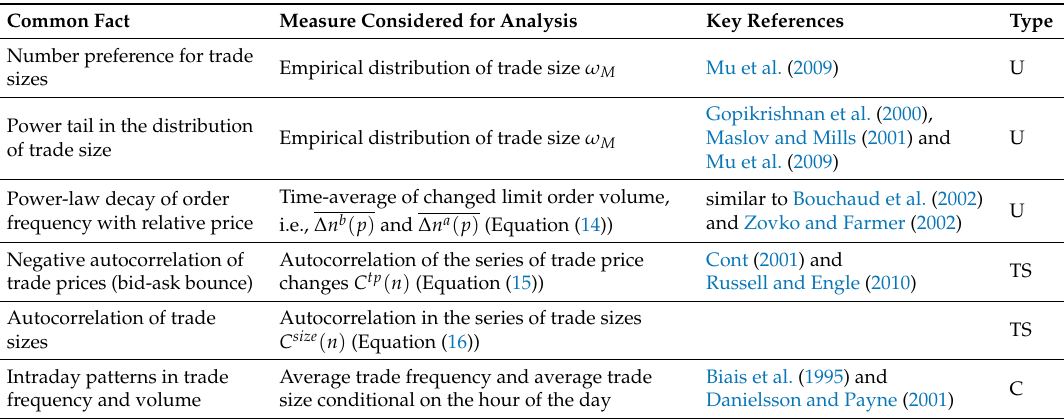
Table 3. Overview of commonly found facts and supporting analyses on trades and limit orders. Type refers to the class of analysis and is one of U (unconditional statistic), TS (time series statistic) and C (conditional